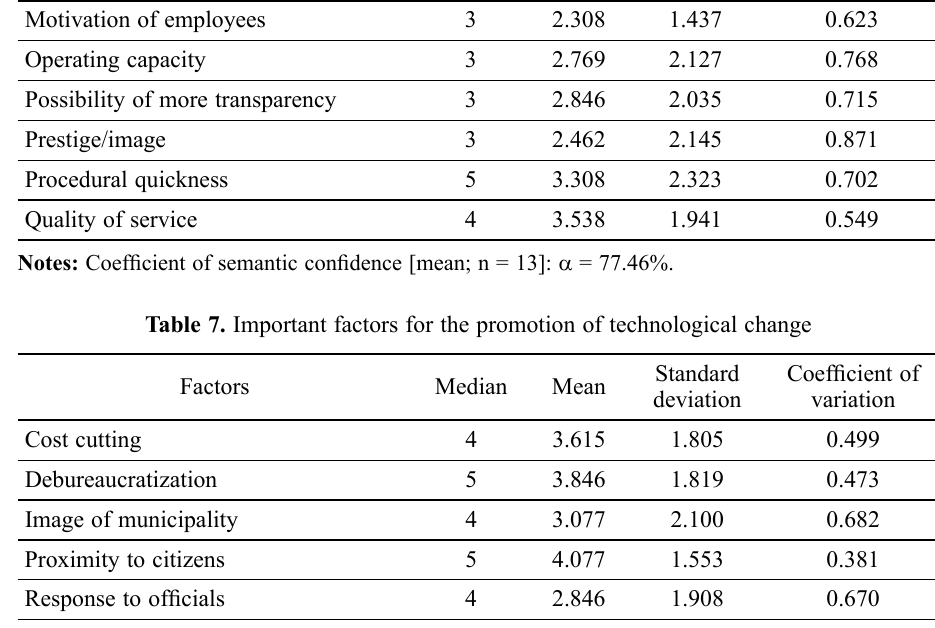
Standard Coefficient of deviation variation